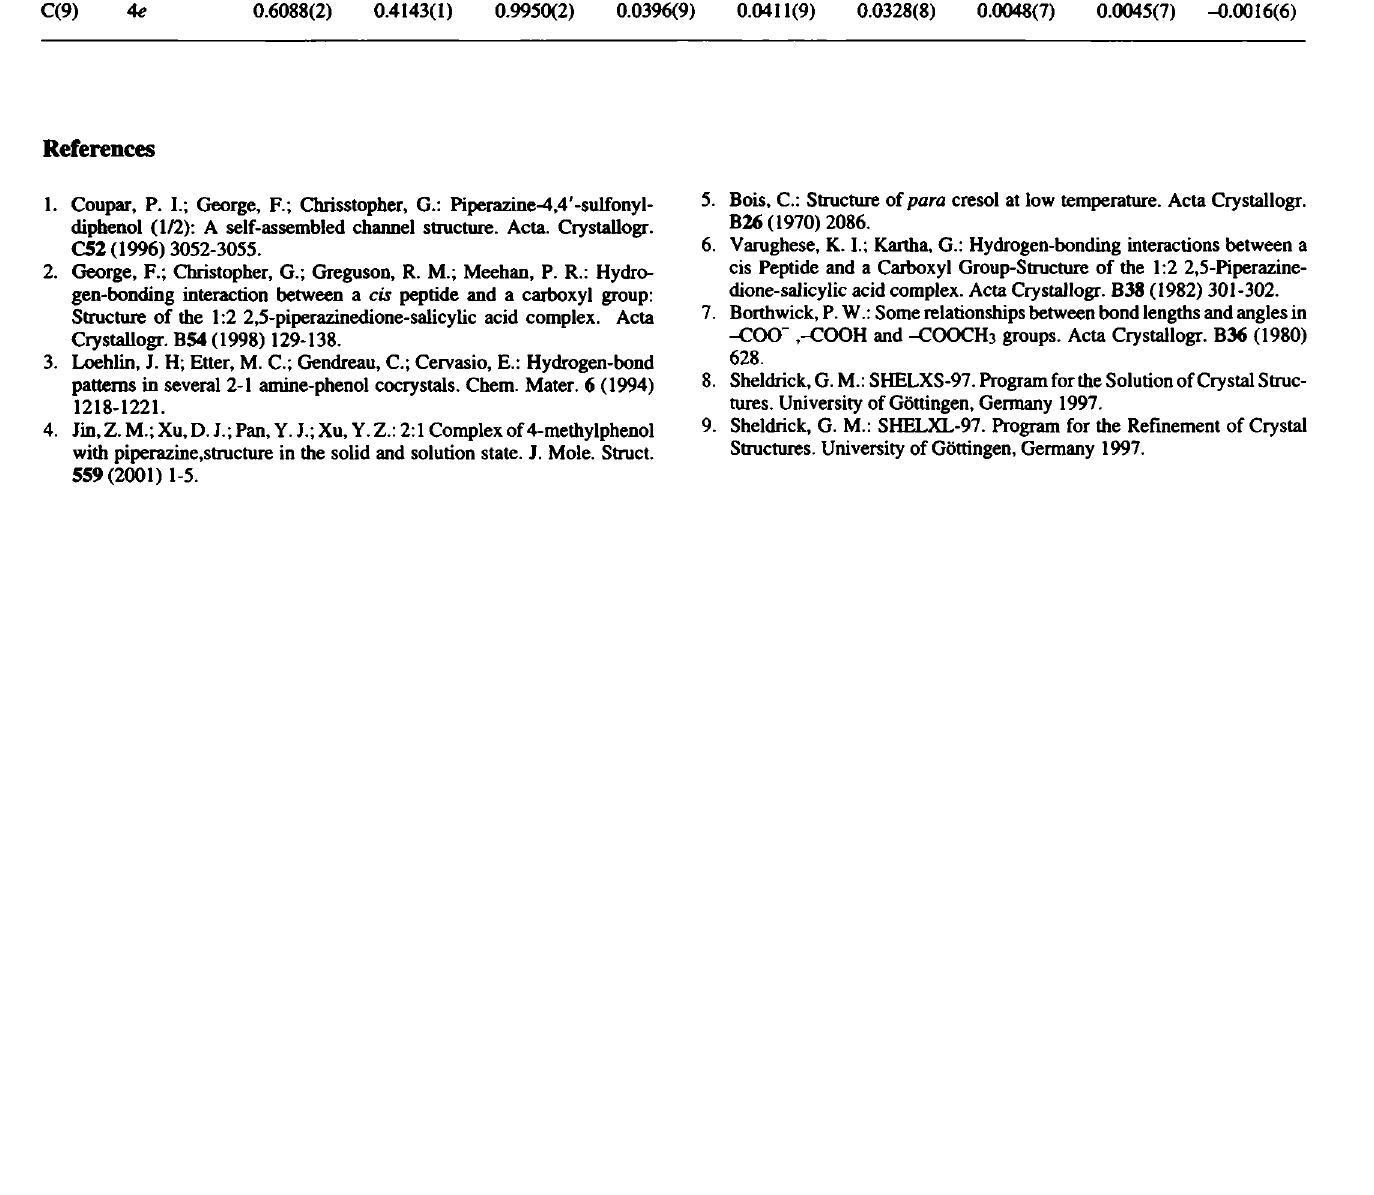
Table 3. Atomic coordinates and displacement parameters (in Ä 2